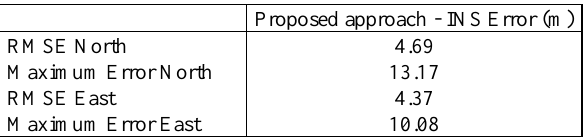
Table 2. Air-Odo – INS performance during 60 Secs of GNSS signal outage.